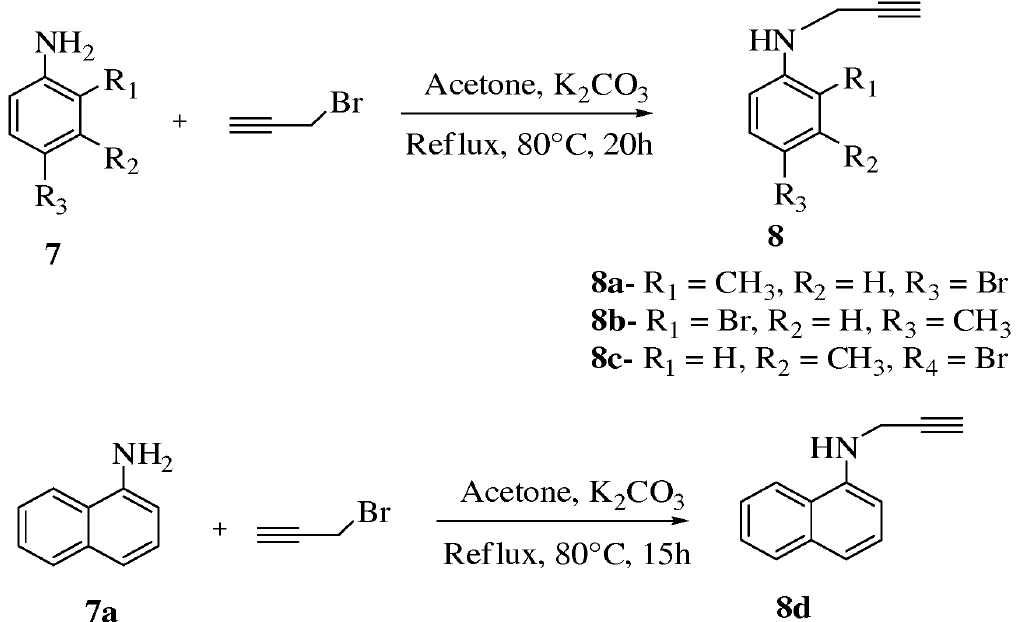
Fig. 4. Synthesis of compounds 8a–d.